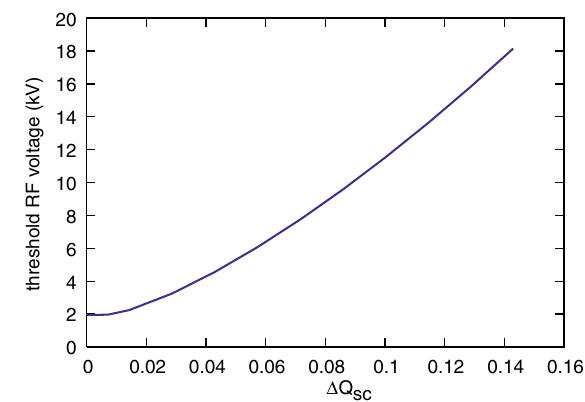
(cid:5) 177 ns . The nominal value is b